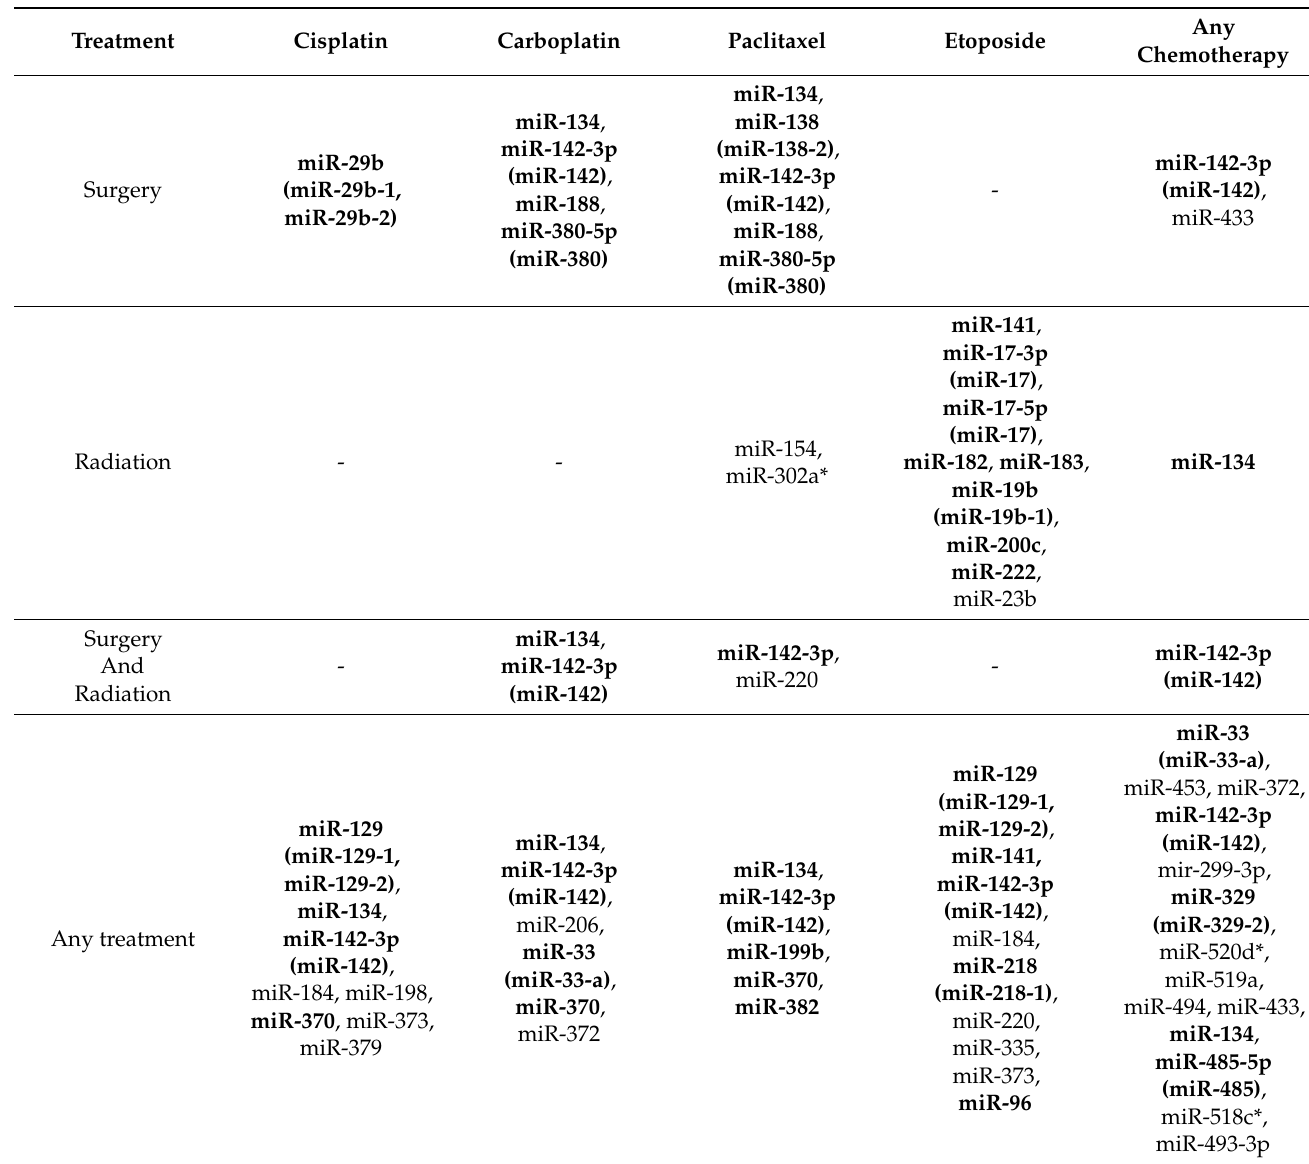
Table 3. Total number of chemosensitive miRNAs when considering administration of specific chemotherapeutic agents in combination with variable administration of surgery and radiation, as evidenced by prolonged disease-specific survival. The miRNAs which produced a significant stratification in the SEER population samples in addition to significance on one or more measures in the NCI-60, MRRCC, CWRU, TCGA, and CCLE are in